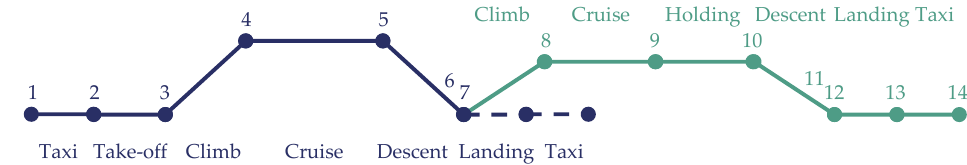
Figure 4. Separate flight mission segments used in the initial sizing